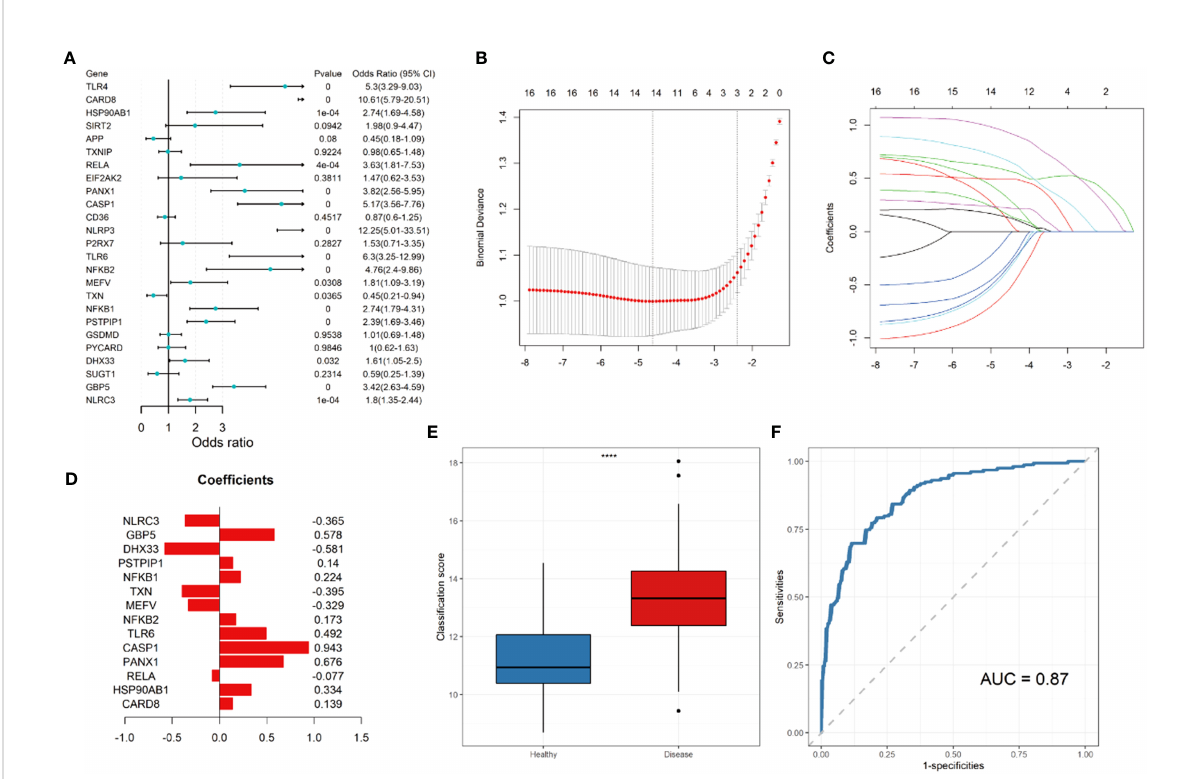
FIGURE 4 Construction of LASSO regression model and receiver operating characteristic (ROC) curve. (A) Forest plot showing the odds ratio and 95% con fi dence intervals for predicting Crohn ’ s disease of each gene. (B) Log lambda values of the genes corresponding to the minimum cross- validation error point. (C) Selection of genes with non-zero coef fi cient for construction of model. (D) Coef fi cients of each gene within the prediction model. (E) Box plot showing the scores of in the disease (red) and control group (blue). (F) ROC curve for prediction of Crohn ’ s disease. **** P ≤